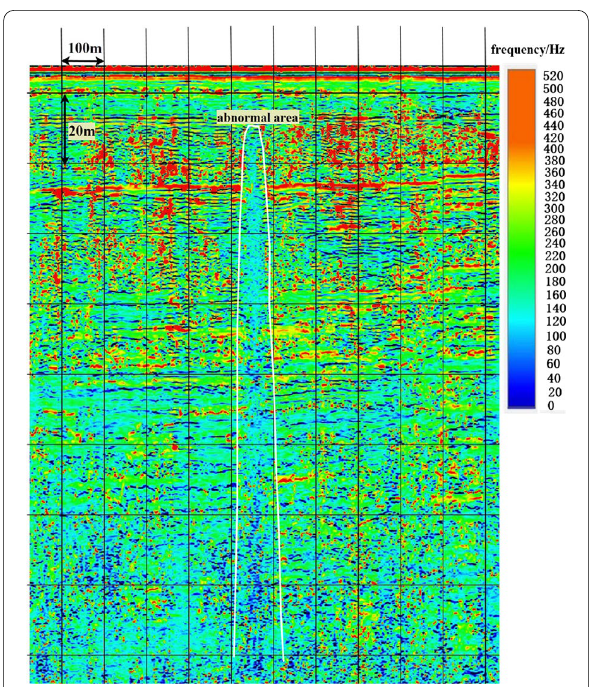
Fig. 11 The acoustic profile in survey area profile2, and the seismic attribute is instantaneous frequency for Fig.